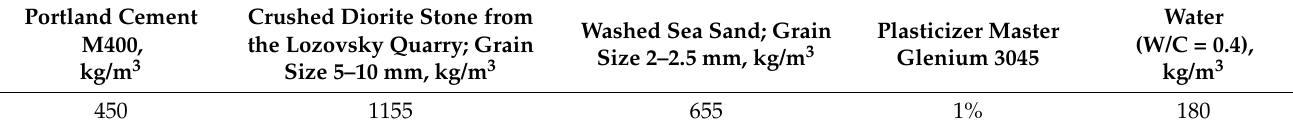
Table 1. Composition of concrete mixture.